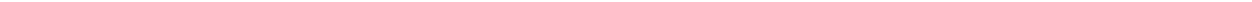
Fig. 6 Mural cell Pparg is required for TZD-driven visceral WAT remodeling. a , b Control and Mural- Pparg KO mice were treated as described in Supplemental Figure 10a. Body weights were measured weekly. Control + Vehicle, n = 8; Mural- Pparg KO + Vehicle, n = 9; Control + Rosi, n = 11;